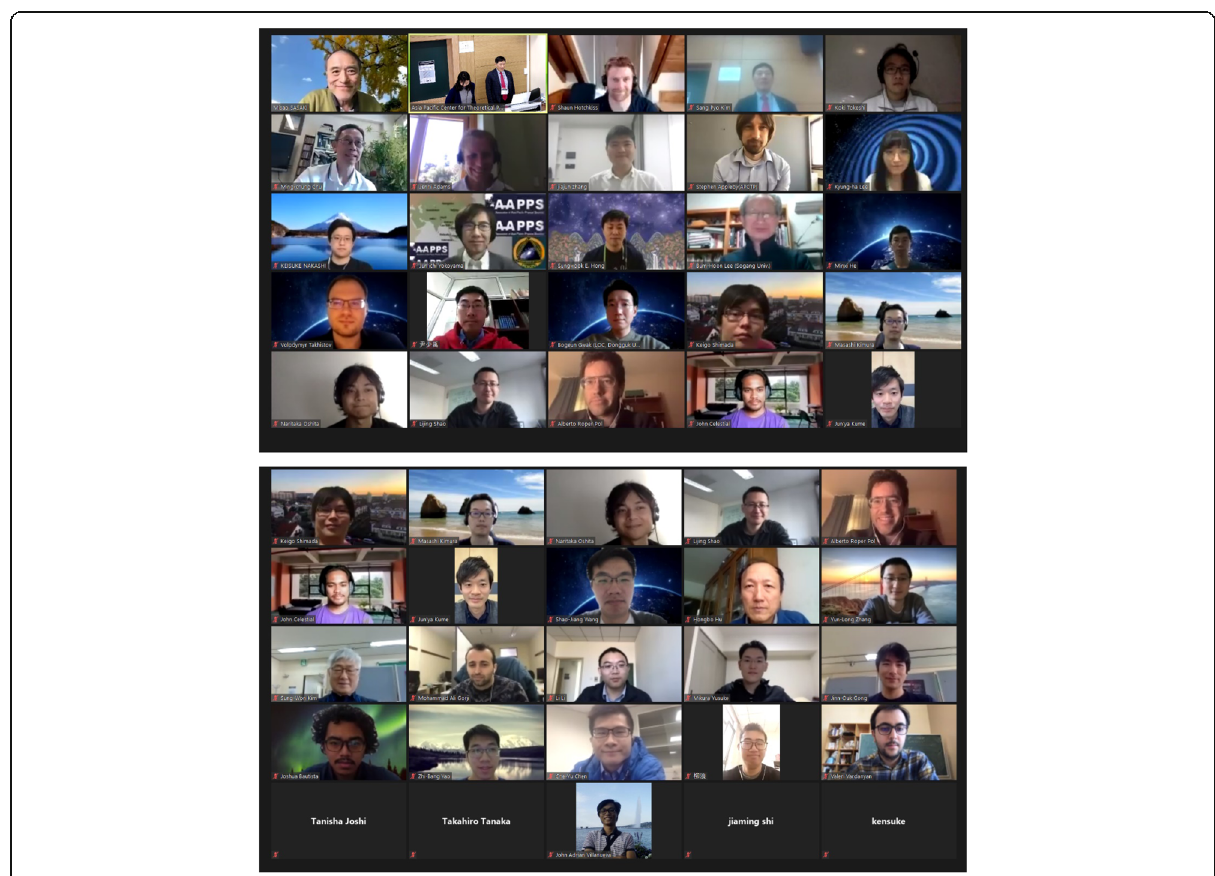
Fig. 3 Photos taken during the 2020 DACG